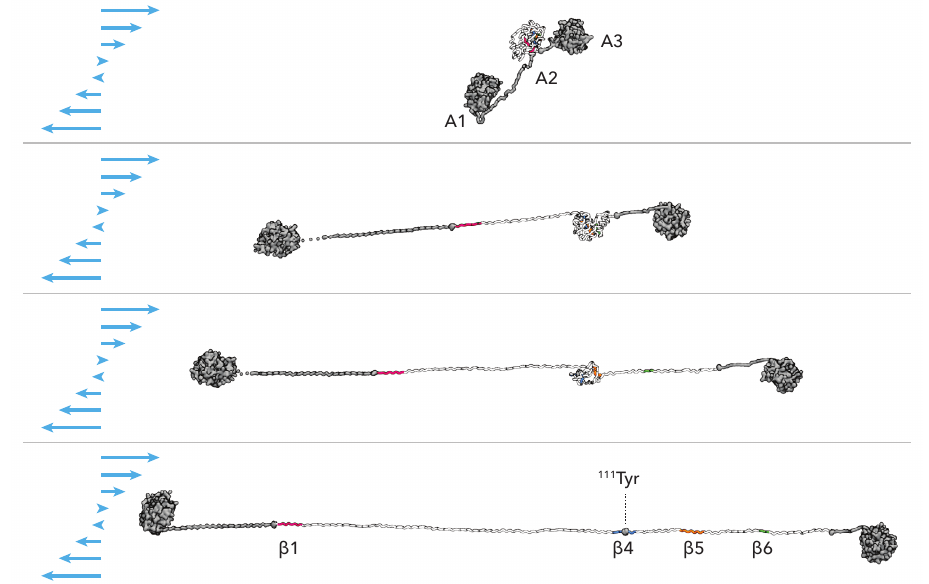
Figure 6. Molecular view of the A1A2A3 construct under shear. Sequence of simulation snapshots that represents the molecular steps of A2 extension under shear. The sets of amino-acids forming in the native state the β strands β 1 , β 4 , β 5 , β 6 are represented with different colors. The cleavage site 111 Tyr is explicitly represented.